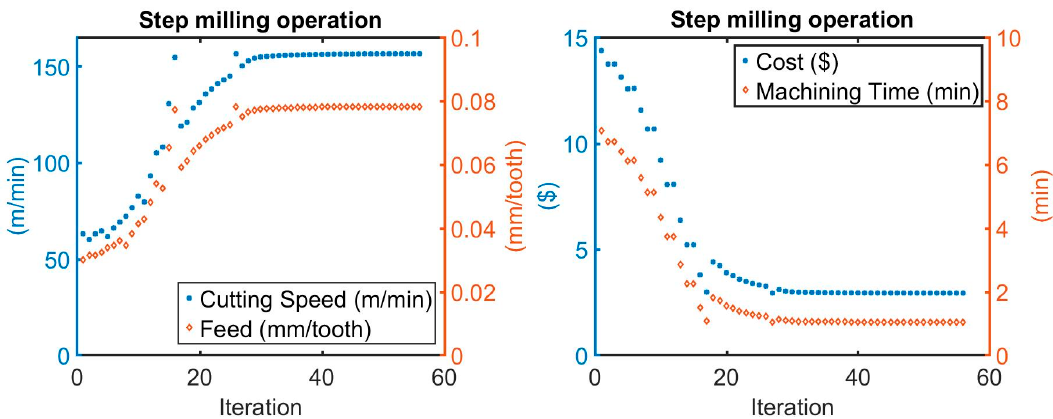
Figure 6. Machining parameters ( left ) and results ( right ) for step operation of the case study. Table 5. Initial and optimum parameters of step milling.